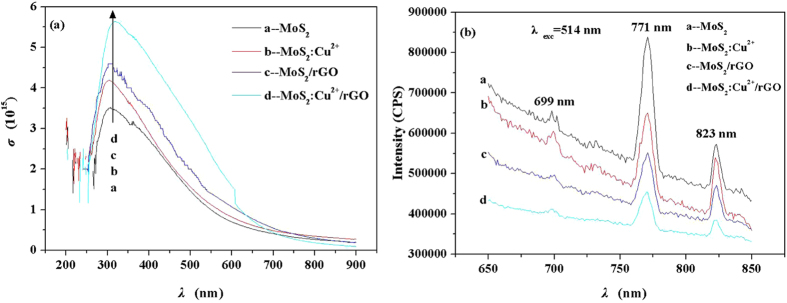
(a) Optical conductivity (σ) and (b) photoemission spectra of the films deposited on glass substrate.